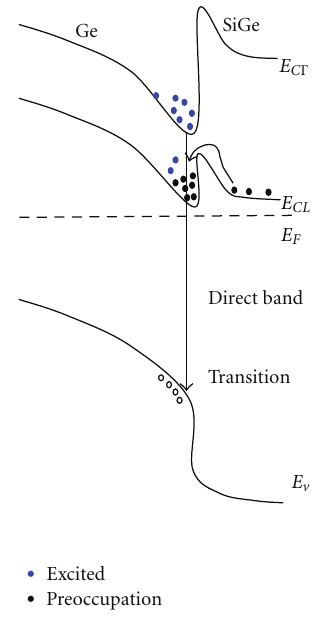
Figure 9: The schematic of band gap of Ge/phosphorous-doped SiGe structure.